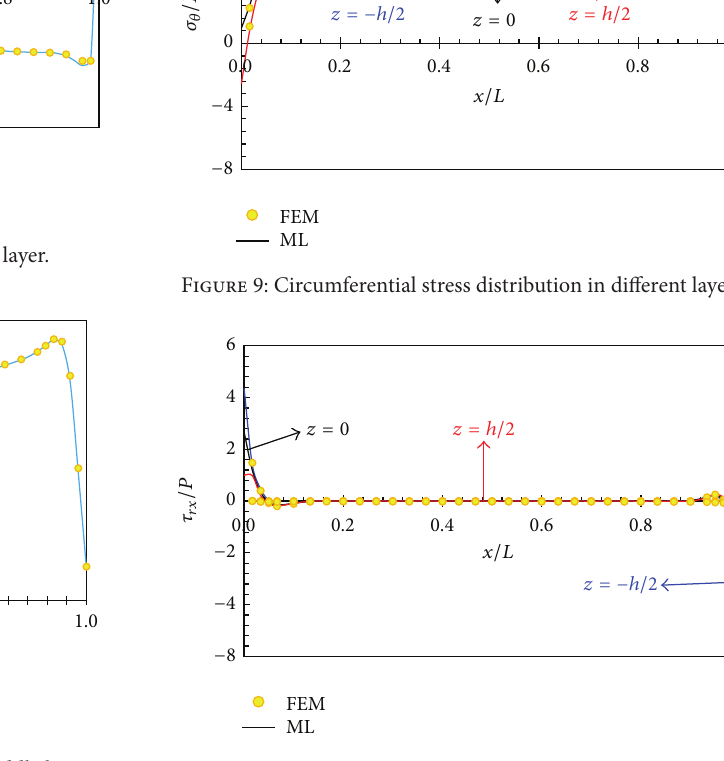
Figure 10: Shear stress distribution in different